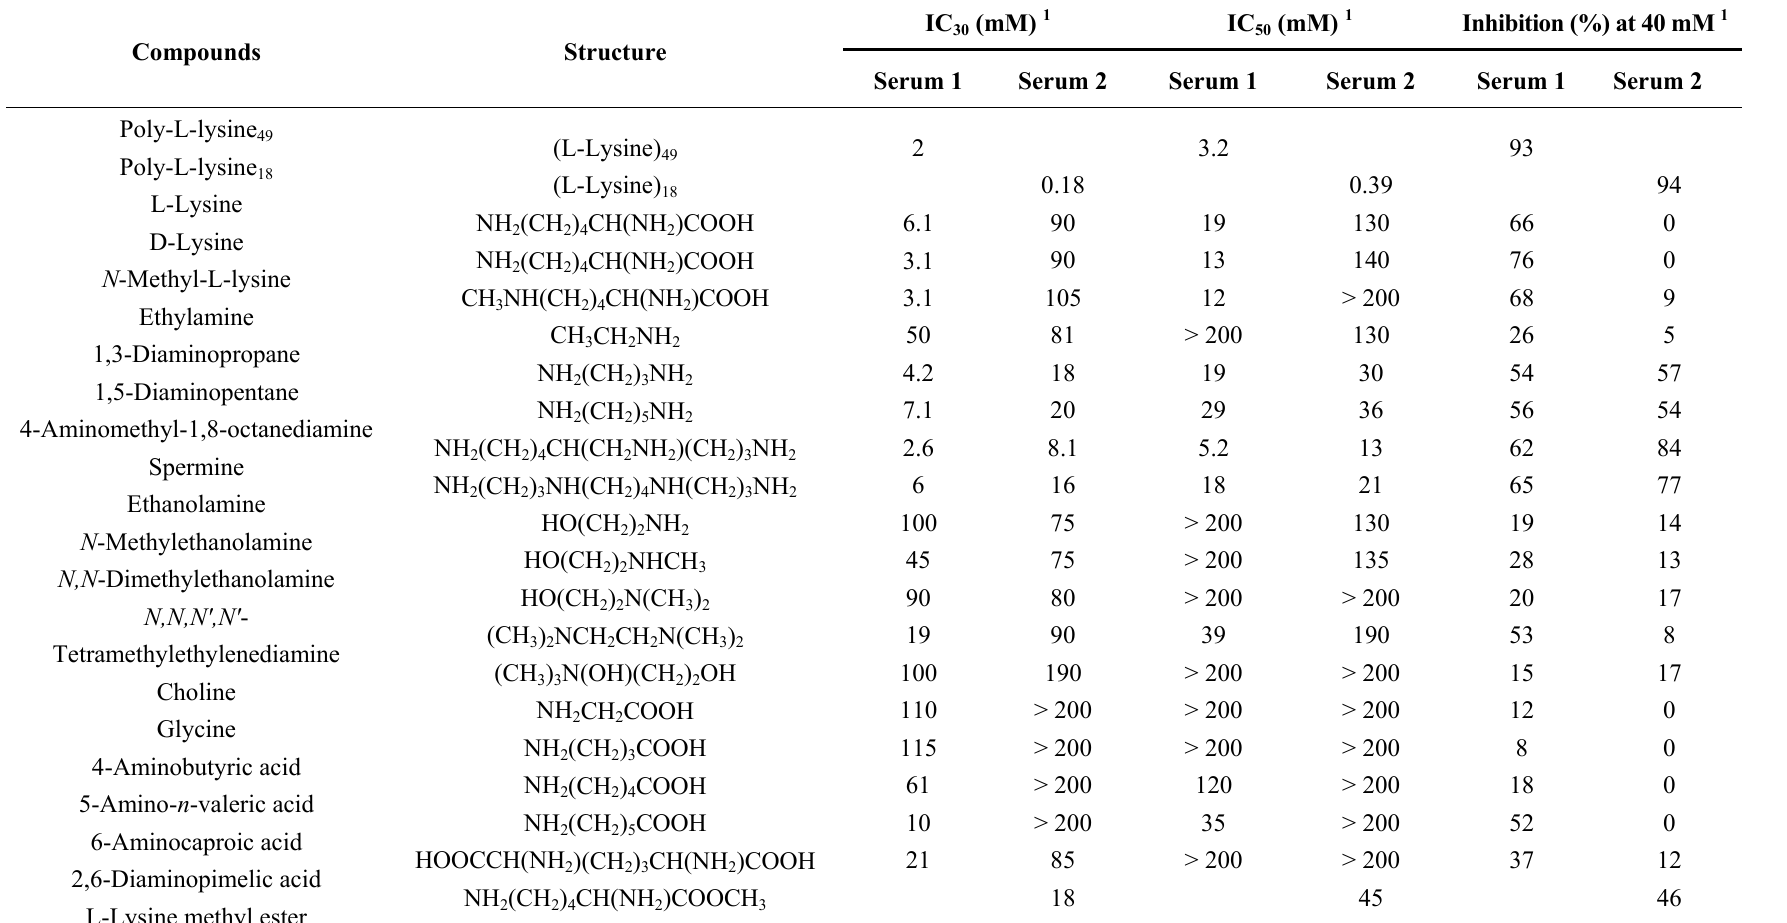
Table 4. Recognition of primary and substituted amines by IgE antibodies.